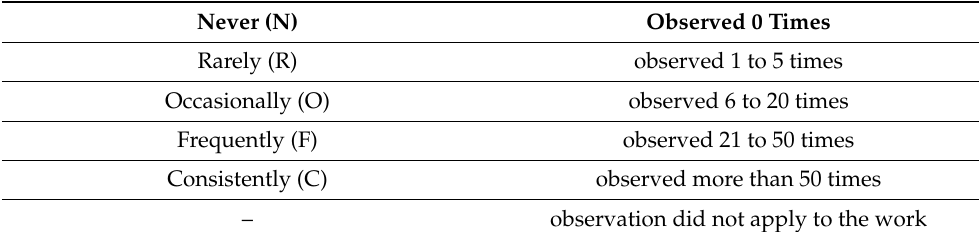
Table A2. Frequency classifications for heedfulness